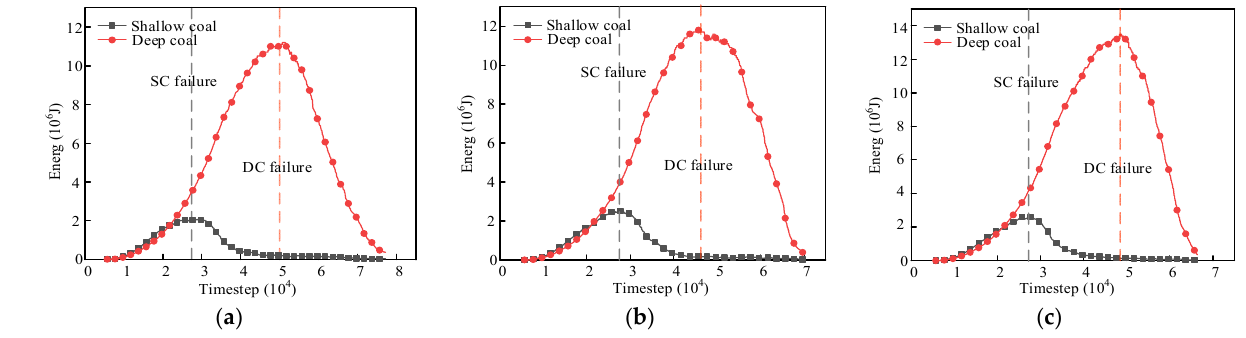
Figure 12. Partition strain energy evolution law of coal mass. ( a ) RSR-1; ( b ) RSR-2; ( c ) RSR-3. In addition, as the roof-1 strength increased, the peak value of strain energy accumu- lated in both shallow and deep coal masses gradually increased. The strain energy in the shallow coal mass increased from 2.06 × 10 6 to 2.49 × 10 6 J, while that in the deep coal mass increased from 1.12 × 10 7 to 1.35 × 10 7 J, supporting the conclusion that increasing roof strength will enhance the energy accumulation limit of coal.